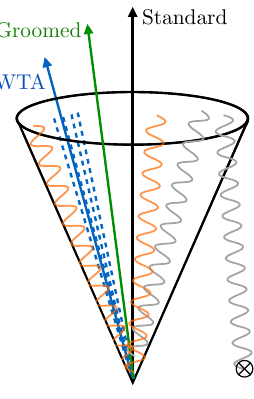
Figure 1 . The various jet axes: the standard jet axis (black) is along the total momentum of the collinear (blue) and soft (orange) radiation. For the groomed jet axis (green) groomed away soft radiation (gray) is not included. The winner-take-all axis (blue) is insensitive to soft